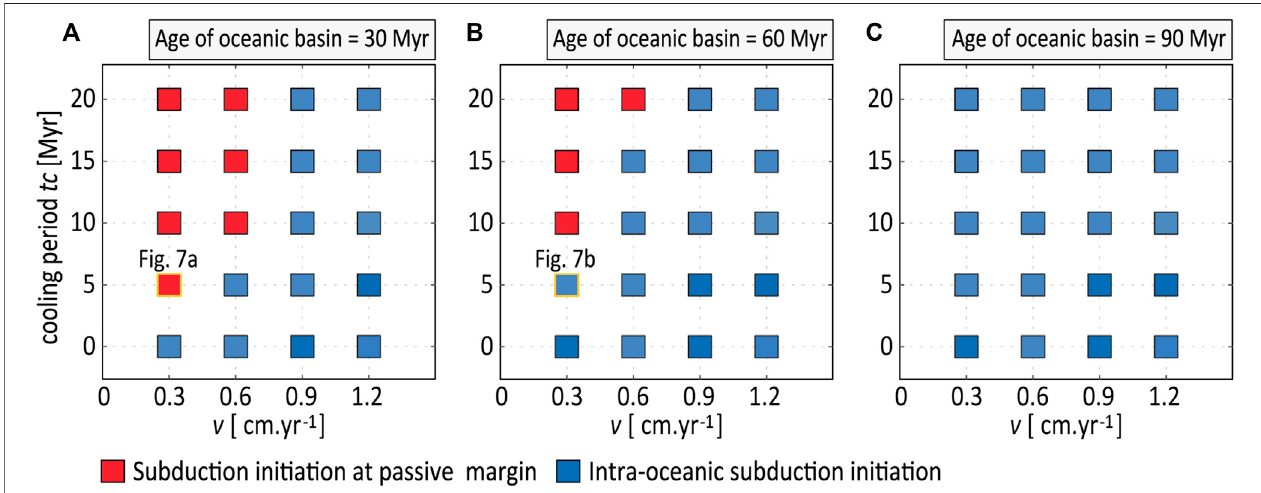
FIGURE 6 | Results of model series 2 with an age dependent thickness of oceanic lithosphere: Domain diagrams mapping the location of subduction initiation againstthecoolingtime (tc) andtheconvergencevelocity (v) duringthesubsequentshorteningperiod.Eachdiagramrepresentsadifferentageoftheoceanicbasin(age of the oceanic lithosphere at the margin) before the start of the experiment.